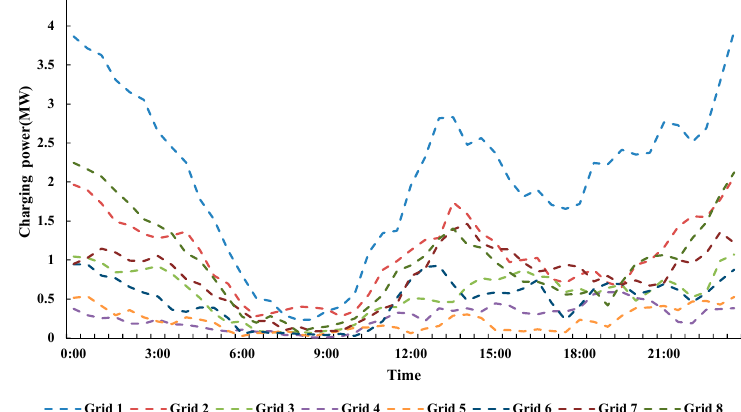
Figure 11. Electric vehicle charging load profile of different grids.